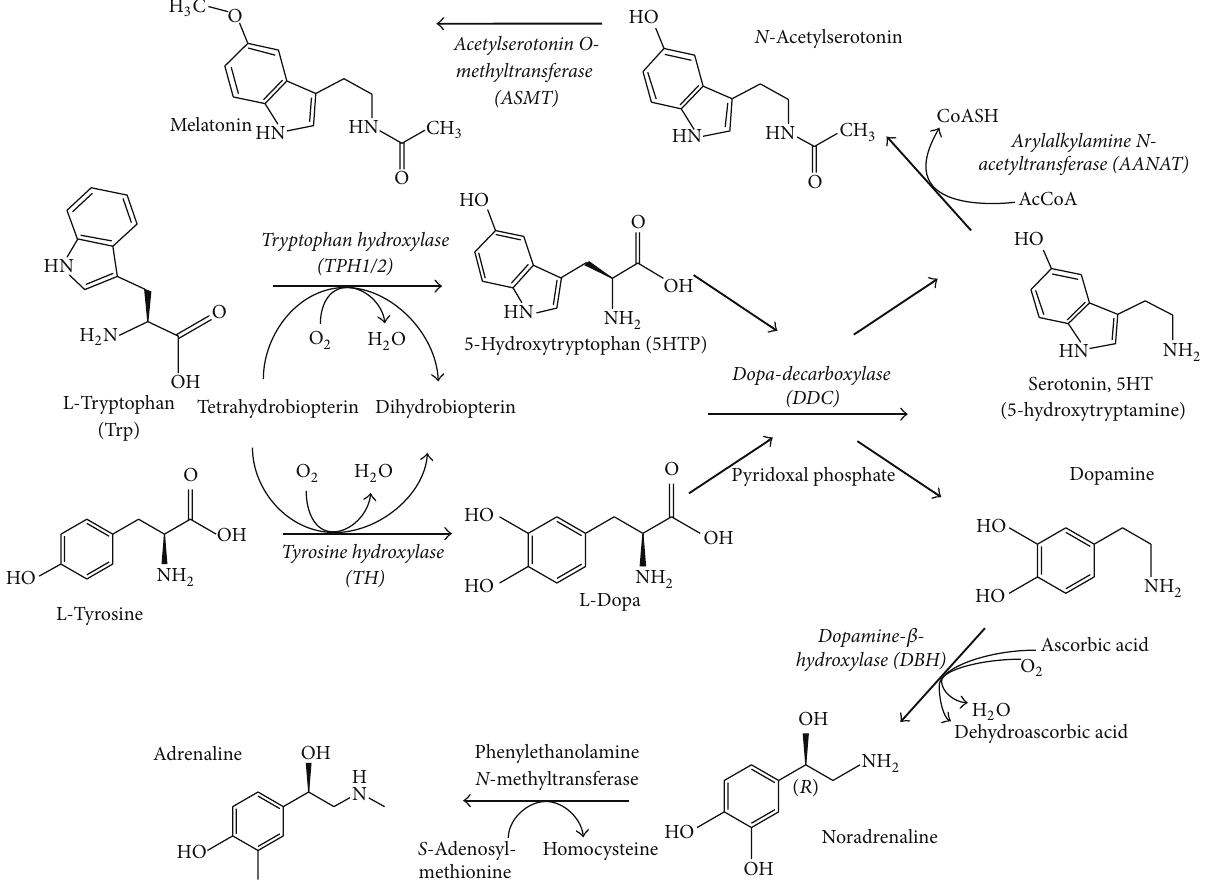
Figure 1: Diagram of biosynthetic pathways of monoamines. Serotonin (5-hydroxytryptamine or 5HT) biosynthesis is carried out by two sequential steps: (1) conversion of the essential amino acid tryptophan into 5-hydroxytryptophan (5HTP) by the enzyme tryptophan hydroxylase (TPH) and (2) decarboxylation of 5HTP to serotonin catalyzed by the enzyme Dopa-decarboxylase (DDC). Two isoforms of tryptophan hydroxylase are known: TPH1, which is found in nonneurons cells, and TPH2, which is predominantly found in neurons cells (mainly in CNS) [32], being both subtypes expressed in pancreatic 𝛽 -cells [33]. Two additional enzymatic steps from serotonin are involved in melatonin synthesis, while DDC is also involved in the synthesis of dopamine from L-Dopa, which in turn is synthetized from the amino acid tyrosine by the action of enzyme tyrosine hydroxylase (TH). Finally, noradrenaline and adrenaline are synthetized from dopamine through the consecutively action of dopamine 𝛽 -hydroxylase (DBH) and phenylethanolamine N -methyltransferase. The enzymes whose gene has been evaluated for expression were highlighted in